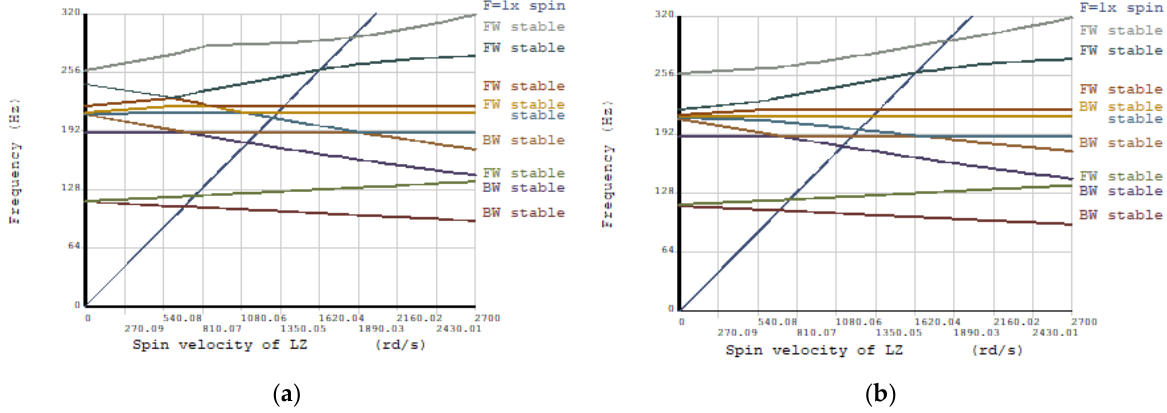
Figure 22. Campbell diagram of front deflection angle non-concentricity: ( a ) θ = 0.1°; ( b ) θ = 0.18°.